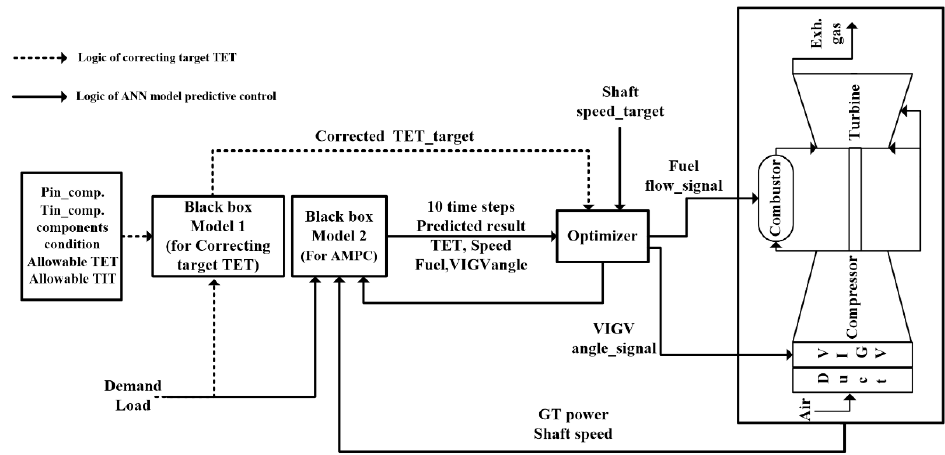
Figure 8. Advanced control logic using artificial neural network (ANN) black box